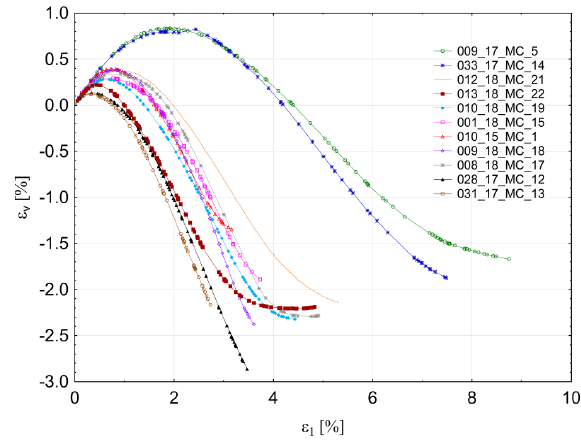
= 0) as a function 2